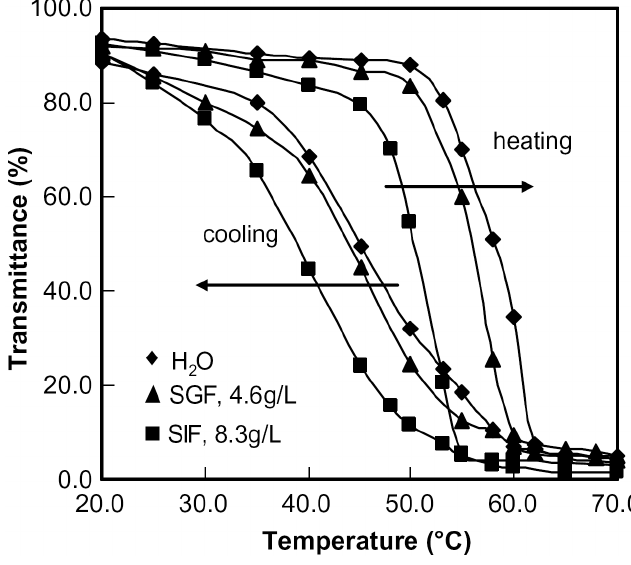
Figure 19. Light transmittance of HPMC solutions (10 wt%) in various solutions as a function of